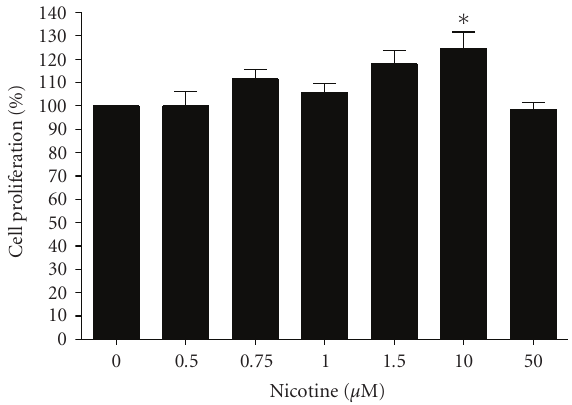
Figure 5: Nicotine does not increase CFTE cell death but increases cell survival at certain concentrations. CFTE29o- cells (1 × 10 5 /mL) were left untreated or stimulated with increasing doses of nicotine (in triplicate) for 24 hours. Cell proliferation was quantified and values are expressed as a percentage change from the untreated cells ( ∗ P ≤ .